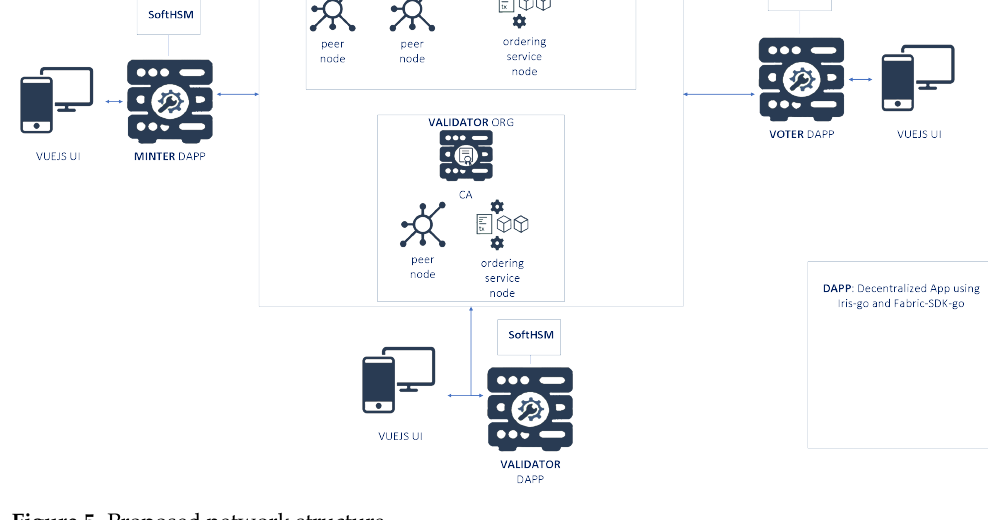
Figure 5. Proposed network structure.